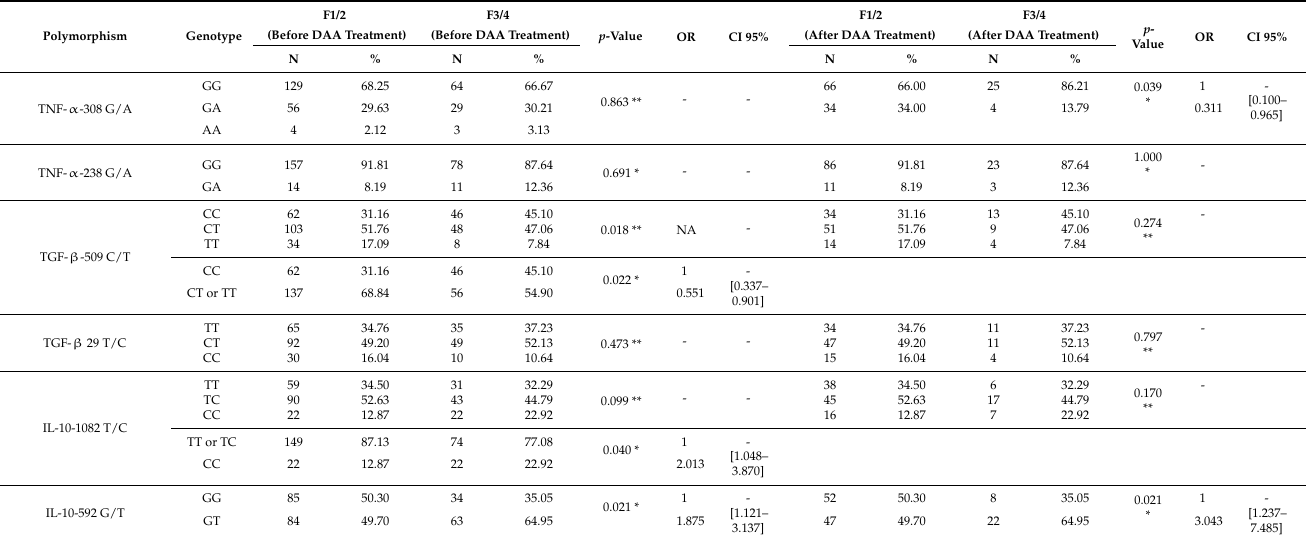
Table 7. Association of cytokine genetic polymorphisms with fibrosis stage before and after DAA